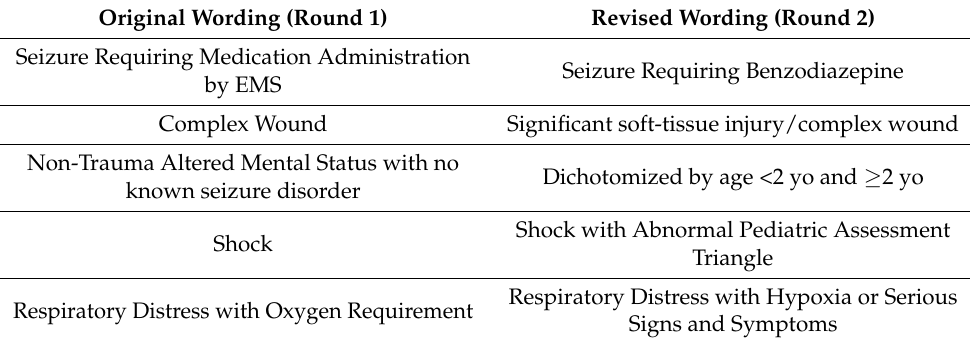
Table 4. PDTree conditions that were reworded by the expert